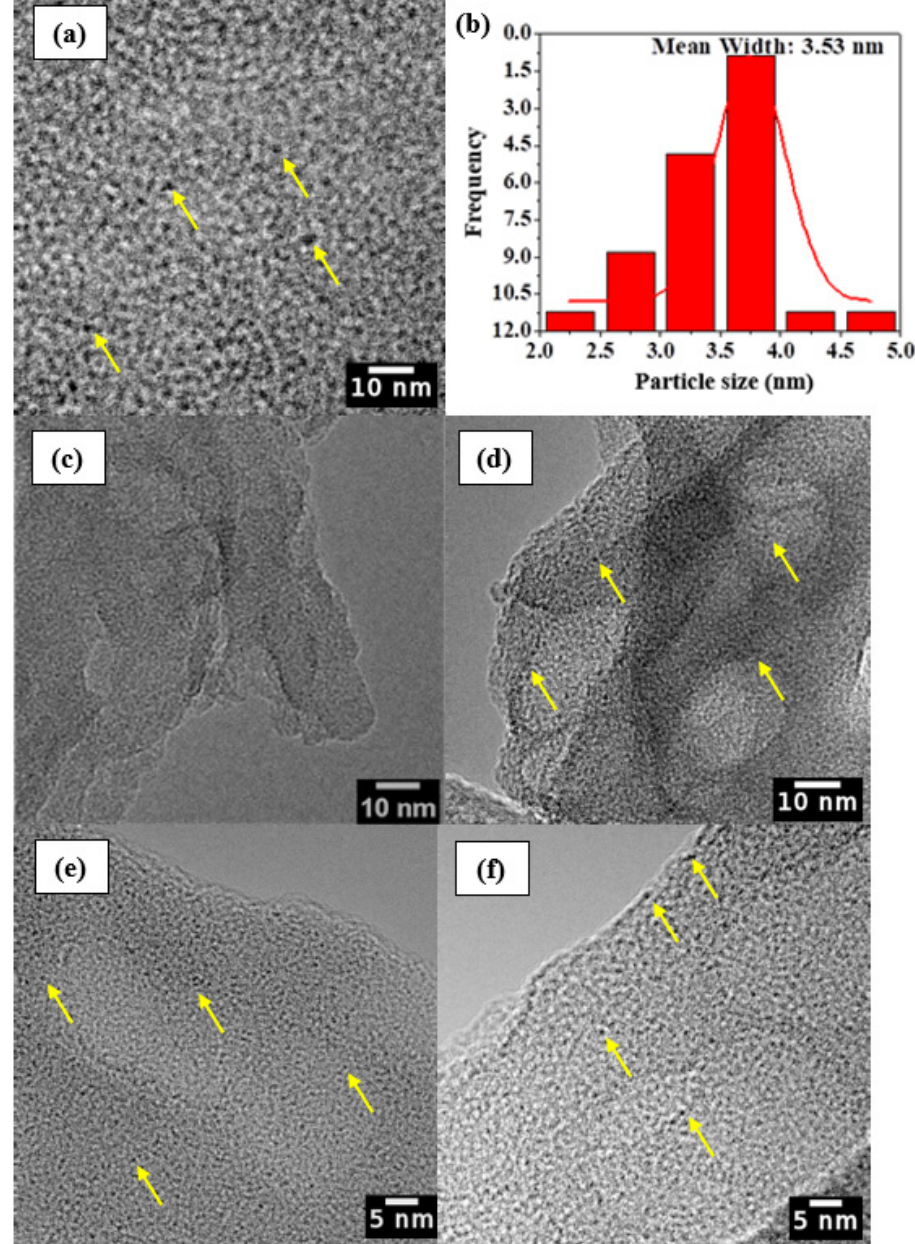
Figure 3. The HR ‐ TEM images and particle size histograms of ( a , b ) CDs, ( c ) pure g ‐ C 3 N 4 , ( d ) Figure 3. The HR-TEM images and particle size histograms of ( a , b ) CDs, ( c ) pure g-C 3 N 4 , ( d ) 0.5CDs/g-C 3 N 4 , ( e ) 1.0CDs/g-C 3 N 4 , and ( f ) 1.5CDs/g-C 3 N 4 . CDs are identified by yellow